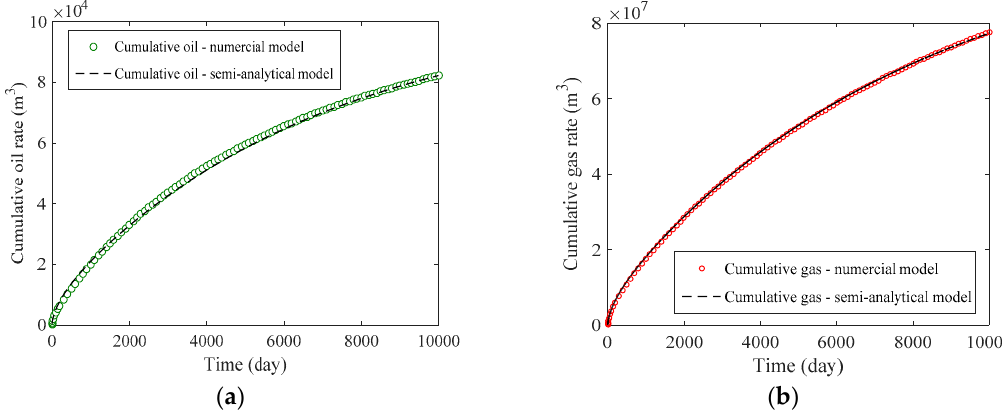
Figure 6. Results comparison of cumulative production between numerical simulation and the semi-analytical method for validation case: ( a ) Cartesian plot of cumulative oil production; ( b ) Cartesian plot of cumulative gas production.